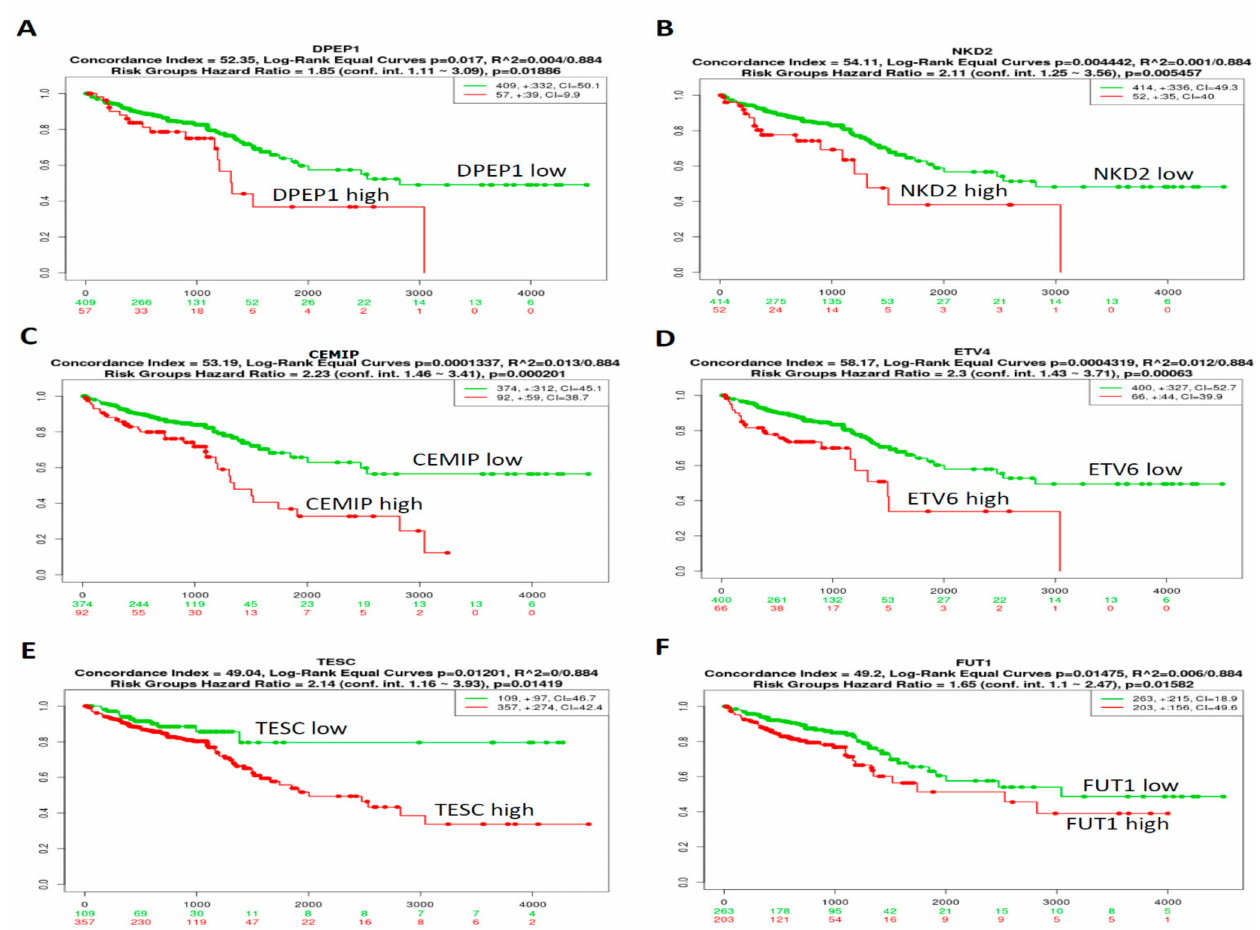
Figure 4. The prognostic value of mRNA expression level of CRC-associated genes in patients with CRC. The relation- ship between DPEP1 ( A ), NKD2 ( B ), CEMIP ( C ), ETV4 ( D ), TESC ( E ), and FUT1 ( F ) expression and survival status in 466 TCGA-CRC patients. p < 0.05 was considered to be statistically